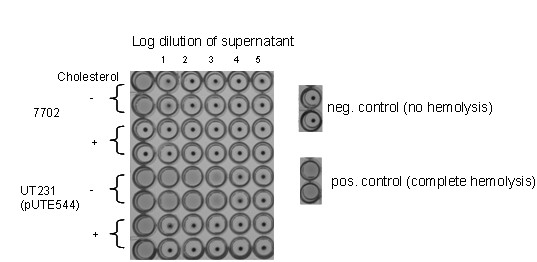
Hemolytic activity of BHI growth supernatants of B. anthracis strains 7702, the parent ALO+ strain, and UT231(pUTE544), the ALO knockout strain complemented in trans with a plasmid bearing the alo gene. UT231 (pUTE544) produces about 1,000-fold more ALO. Hemolytic activity is reduced upon the addition of 1 μg/ml cholesterol. Results are representative of at least three independent experiments done in duplicate.